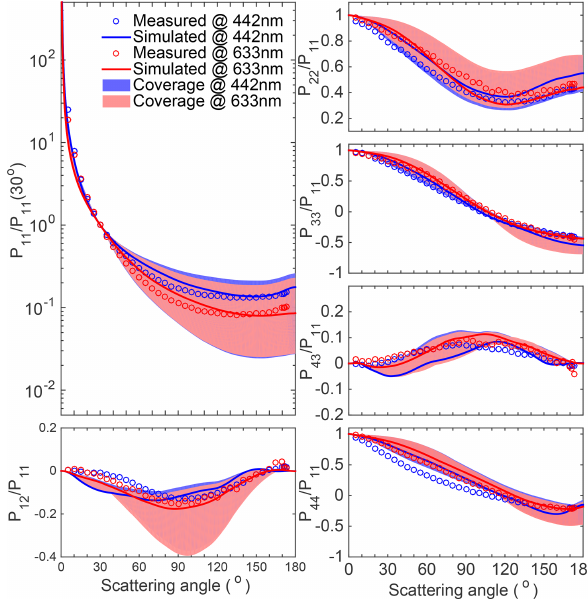
Figure 6. Comparisons of the scattering matrix elements between the measured and computed results for feldspar at wavelengths of 442 and 633nm. The hallow dots indicate the measurement, the thick lines indicate the optimal computed results, and the shaded areas indicate the variety range by different RIs. The optimal RI at both wavelengths is 1 . 55 + 10 − 3 i .